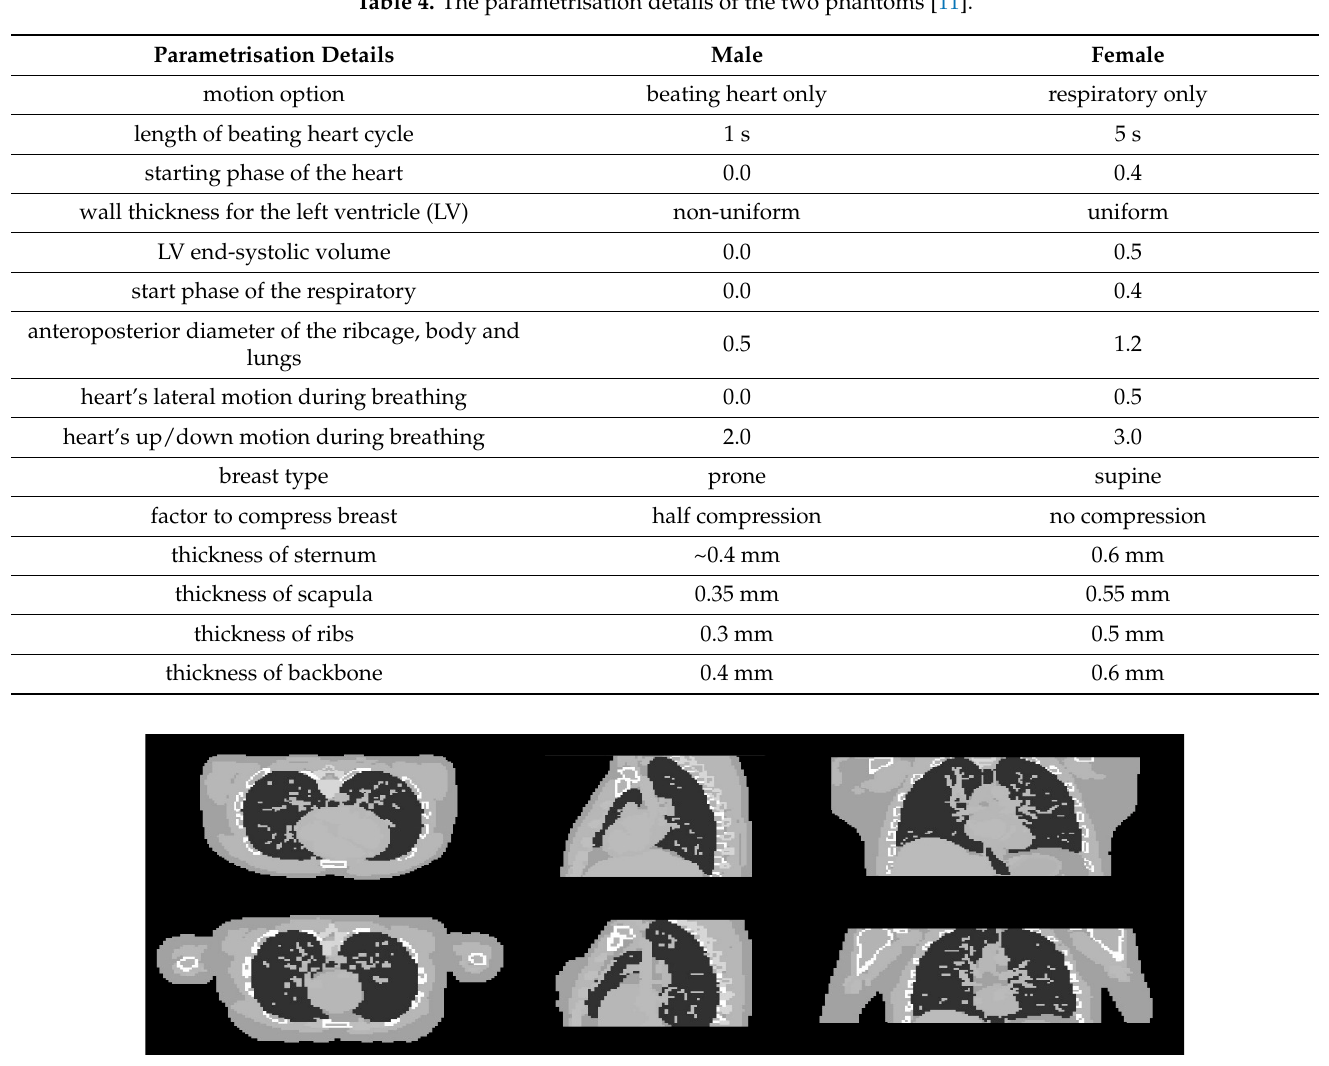
Figure 9. The difference between reconstructed images using proposed methods with reference data using the set of hy- perparameters from the proposed algorithm with respect to different angle arrangement. The display window is [0–0.02].